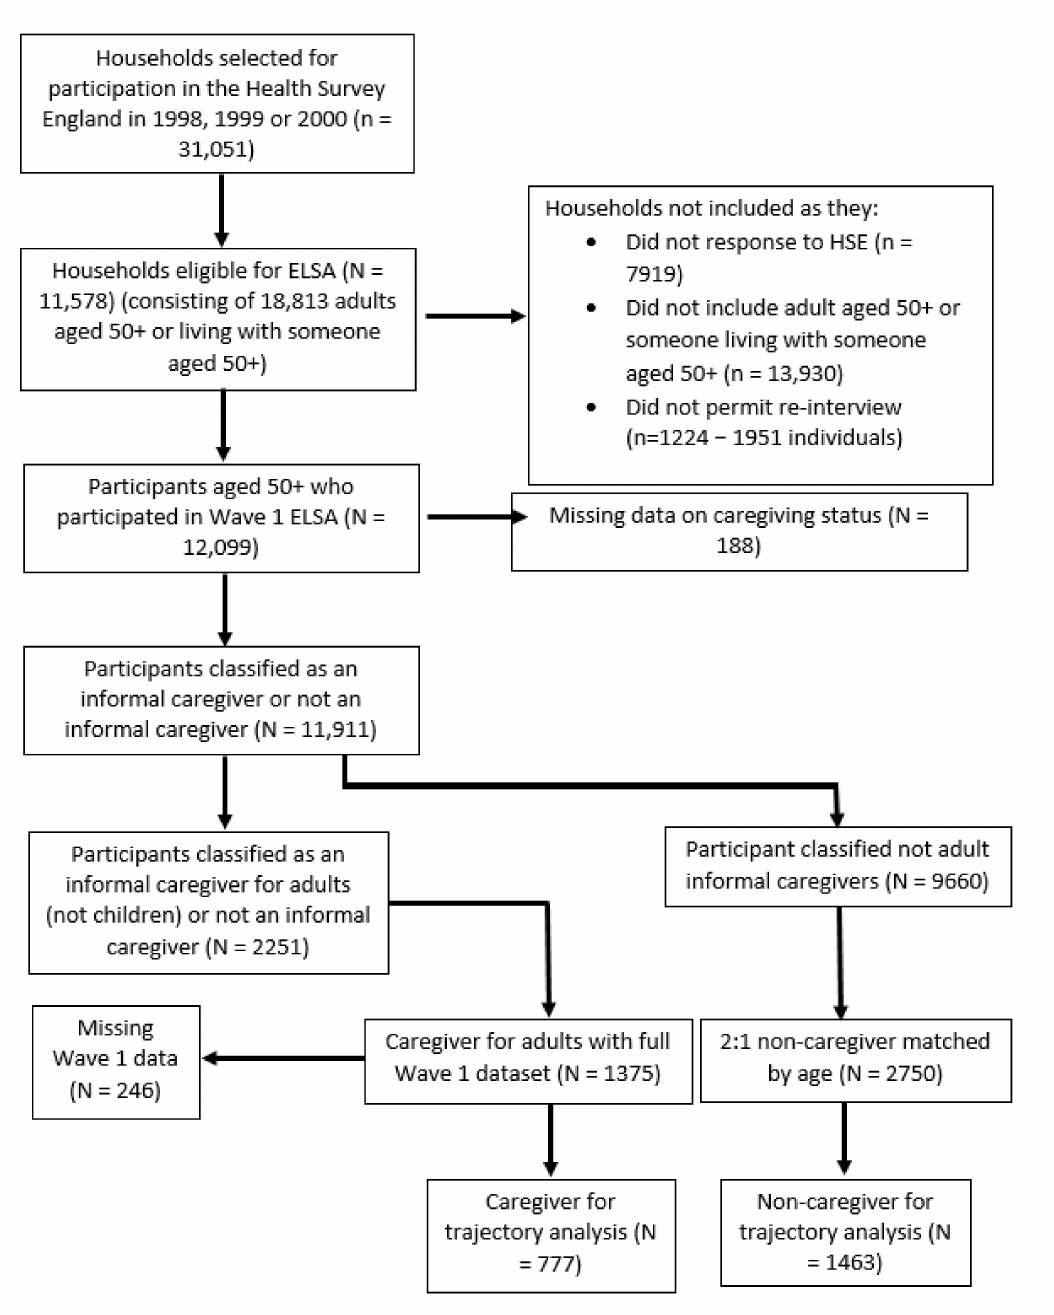
Figure 1. Cohort flow chart of English Longitudinal Study of Ageing (ELSA) Wave 1 participants analyzed as informal caregivers and non-informal